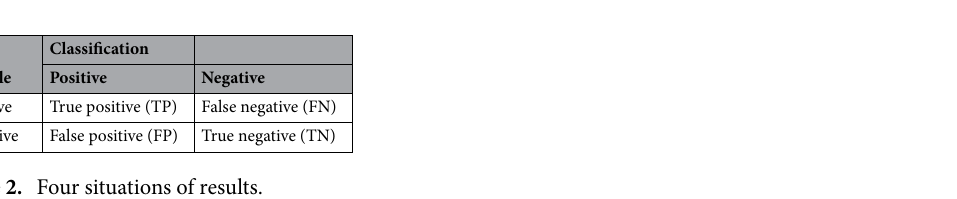
Table 2. Four situations of